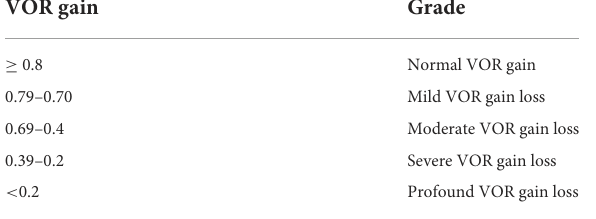
TABLE 2 VOR gain loss grading